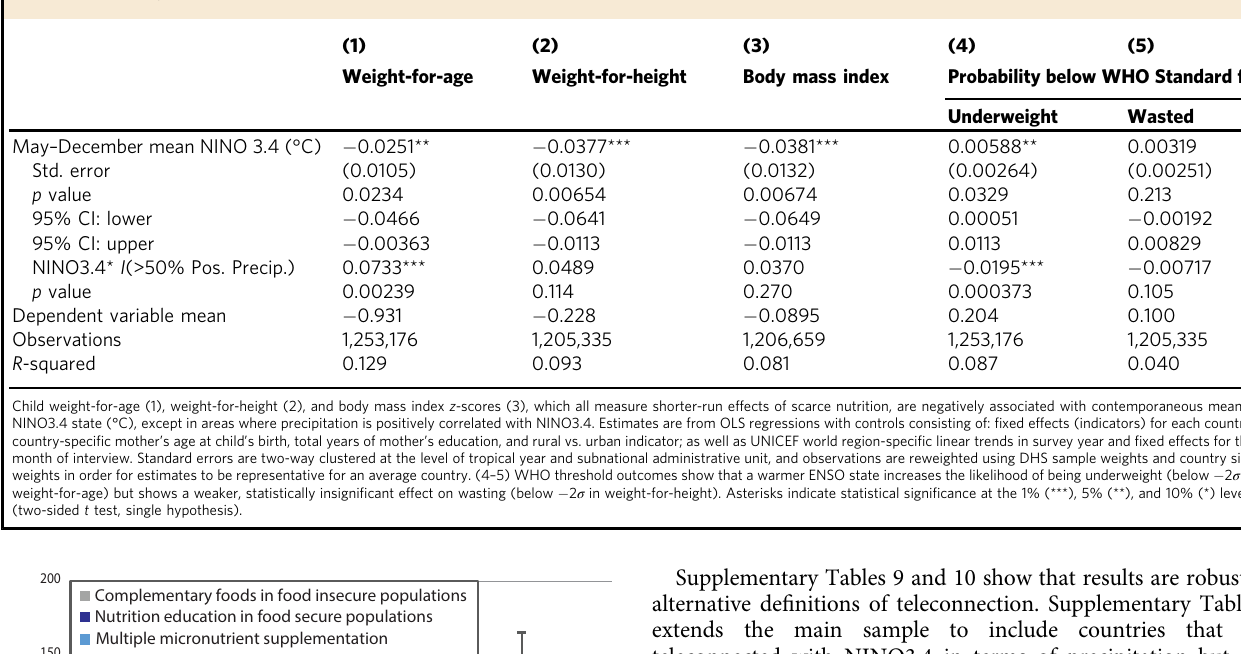
Table 1 Anthropometric effects of ENSO.